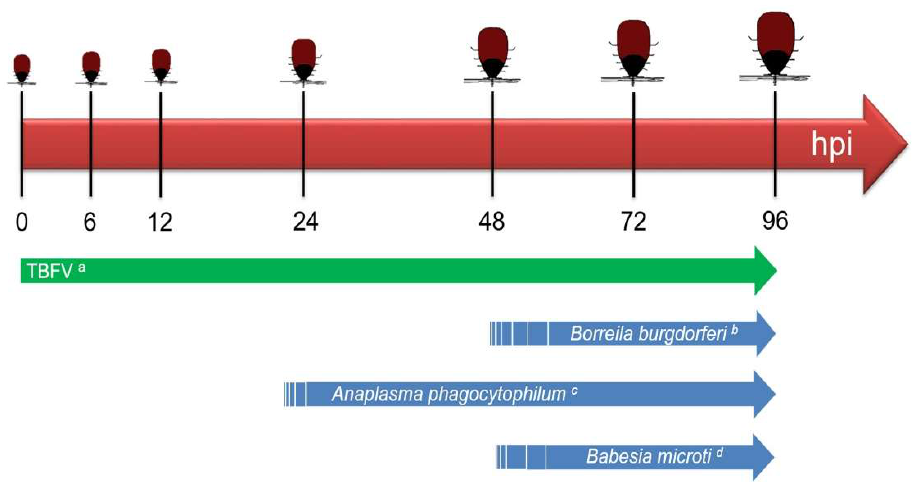
Figure 2. Timeline of pathogen transmission by a single infected nymphal tick. Solid region of arrow indicates experimentally validated time points of pathogen transmission. Dashed region of arrow indicates estimated timeline of earliest pathogen transmission. TBFV = Tick-borne flavivirus. a TBFVs (Powassan virus and Tick-borne encephalitis virus) can be transmitted to the host by an individual Ixodes tick within minutes to a few hours of tick attachment [24–27]. b The earliest documented Borrelia burgdorferi transmission by a single infected nymph was between 47–49 h after tick attachment [21,22]. c The earliest documented Anaplasma phagocytophilum transmission by a single infected nymph was observed by 24 h of tick attachment [21]. d The earliest documented Babesia microti transmission by a single infected nymph was observed after 54 h of tick attachment [18,28].